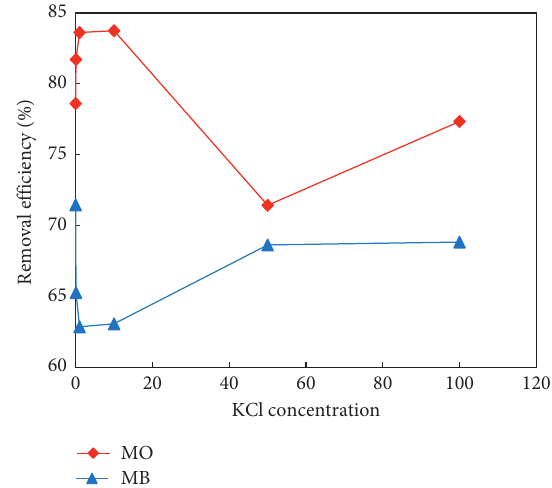
Figure 8: Influence of pH on the adsorption capacity of MB and MO by UiO-66-NO 2 .